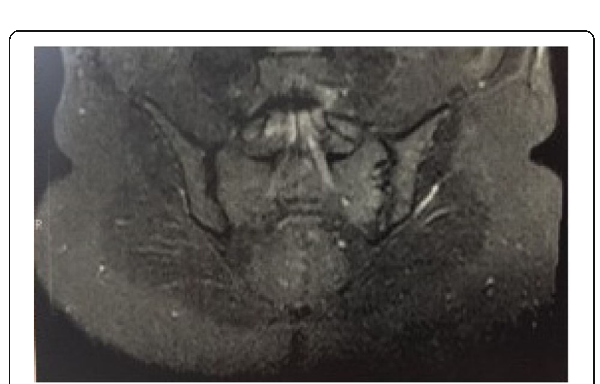
Fig. 2 (abstract P443). Magnetic resonance imaging showed evidence of sclerosis and subchondral cortical thickening of both articular faces, bilaterally and thin subchondral bone edema, mainly in the